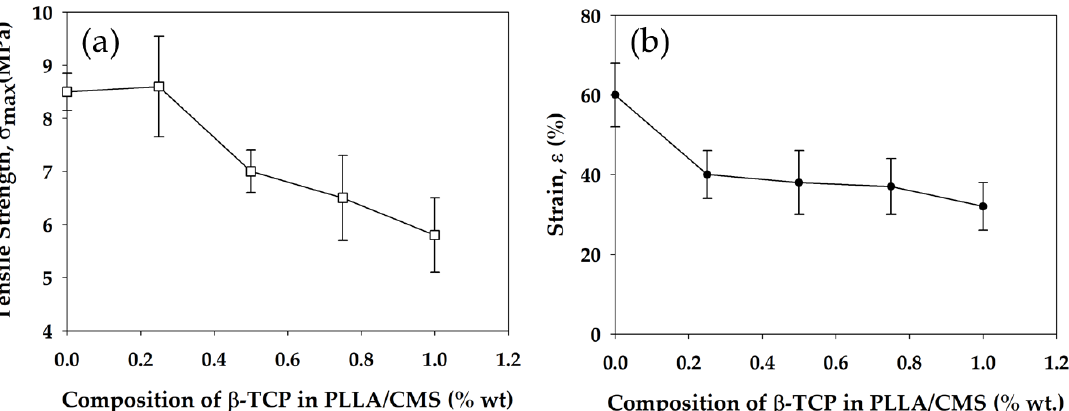
Figure 13. Changes in tensile strength ( a ) and strain ( b ) of PLLA / CMS / β -TCP composite nanofibers with the increase of the β -TCP content in the composition.